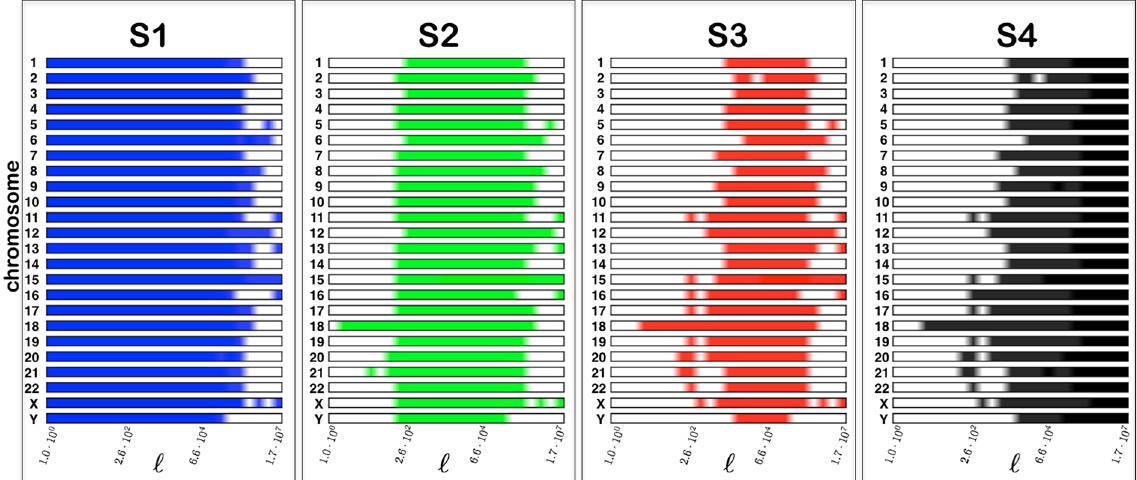
Figure 4. Hierarchy of symmetries in Homo Sapiens - All chromosomes. The symmetry index  I ( ) function of the scale  for the full set of chromosomes in Homo Sapiens. The brighter the color, the larger is the relevance of the symmetry S 1 , S 2 , S 3 , or S 4 (more precisely, if I min is the minimum I S in each chromosome, I